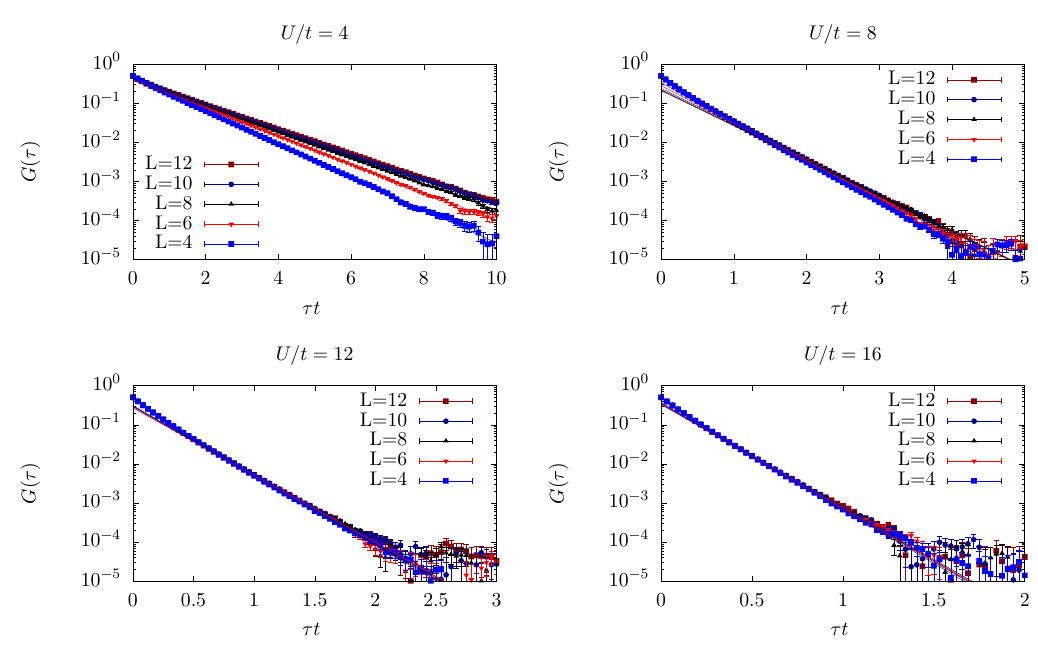
Figure 4: QMC data for the single particle Green function of Eq.